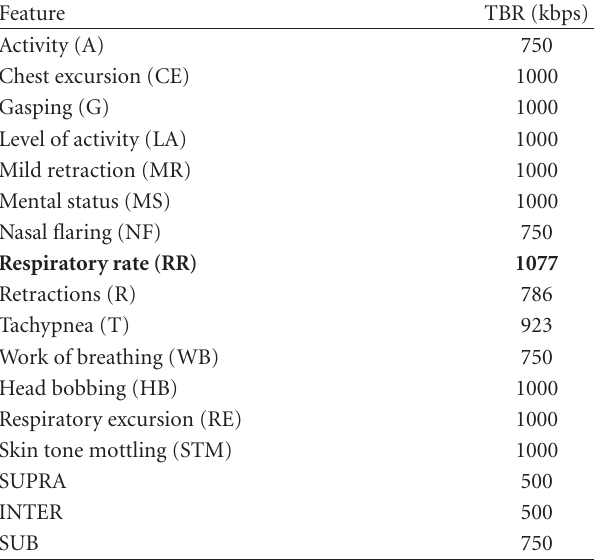
Table 3: Required bit rate for DL in medical features pertaining to pediatric respiratory